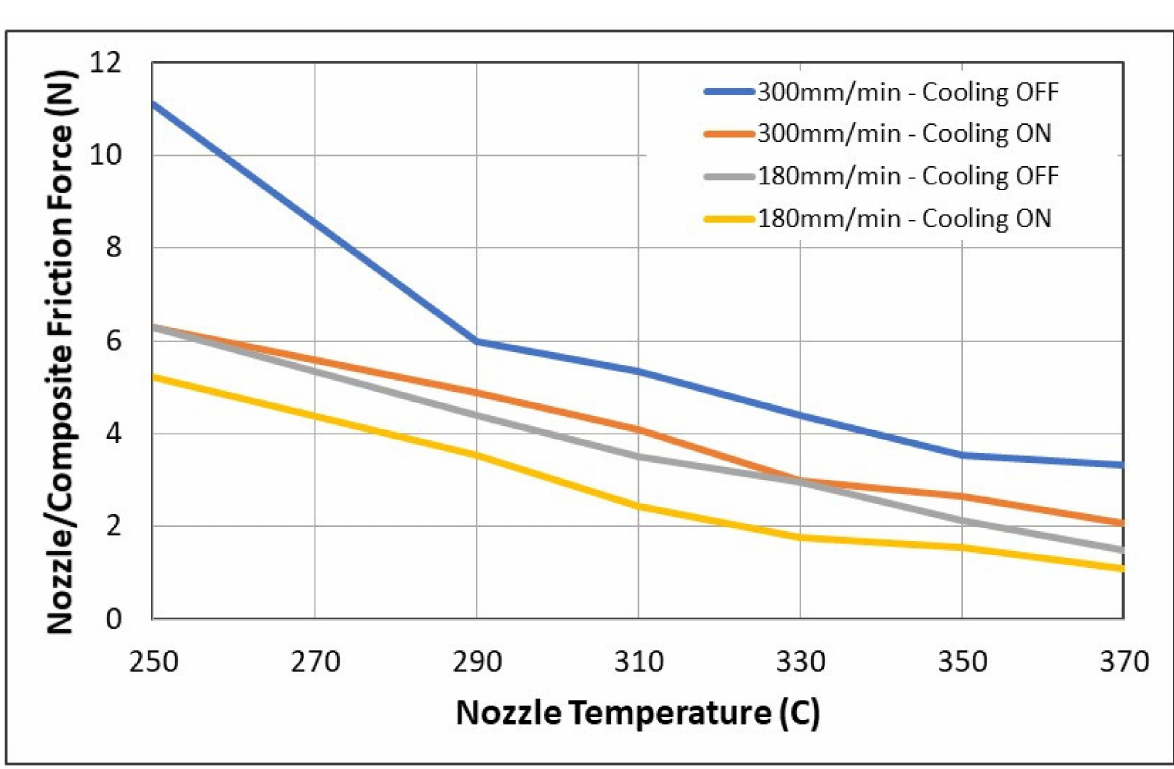
Figure 13. Nozzle/composite friction force of pulling the composite tow through the